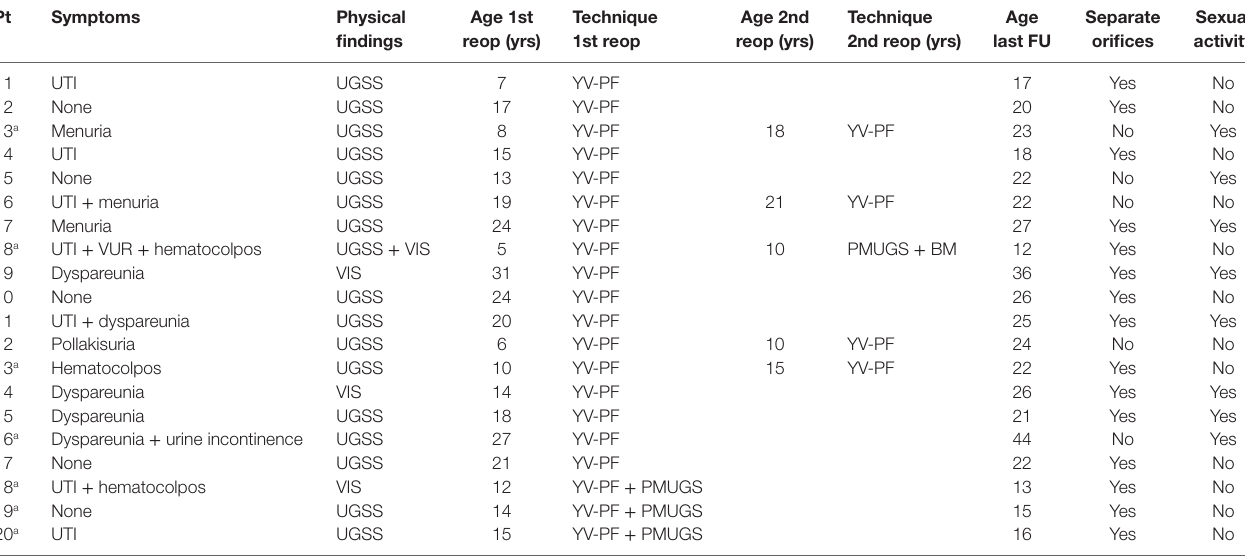
TaBle 1 | clinical data, surgical procedures, and final results of the 20 patients.